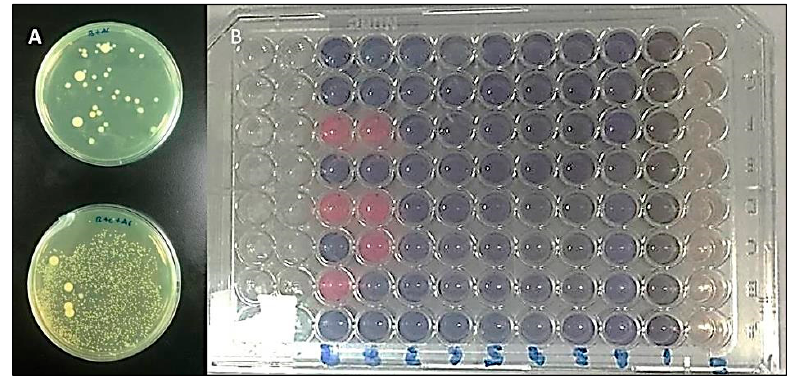
Figure 2. ( A ) Comparison of T. forsythia growth in control and after treatment with C. zeylanicum, ( B ) Broth microdilution method to evaluate minimum inhibitory concentrations (MIC) and minimum bactericidal concentration (MBC) of plant extract against bacteria.